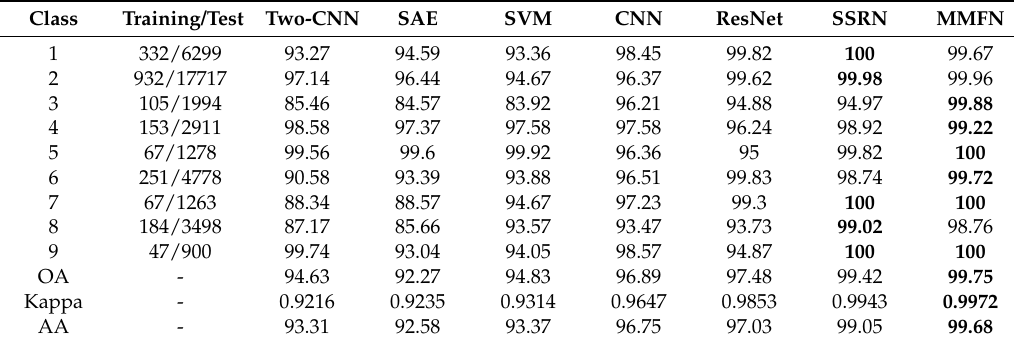
Table 10. Class-specific accuracies (%) of the UP Data Set.